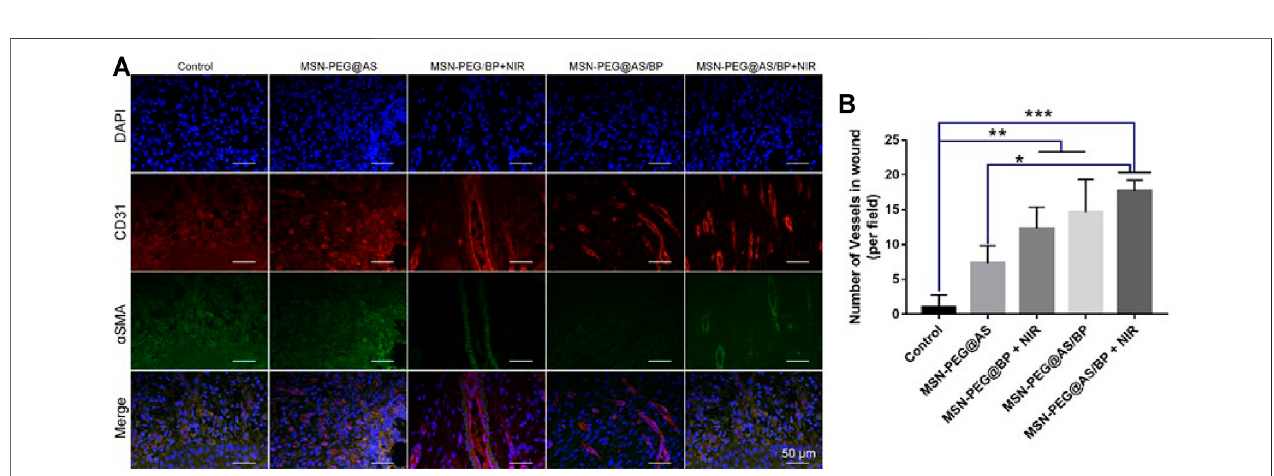
FIGURE 9 | (A) Immuno fl uorescence staining of DAPI, CD31, and α -SMA in the wounds at Day 7. (B) Quantitative analysis of number of blood vessels.